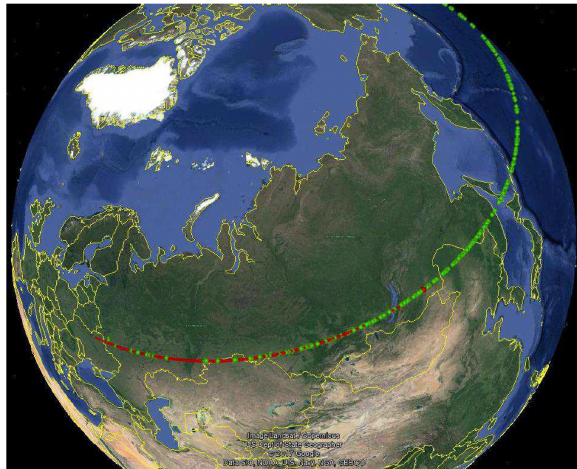
Figure 6. Entry points region for Chelyabinsk meteoroid being ob- served with SODA system by single SC (variant 1). Green points correspond to length of arc 8 hours, red — 15 hours.